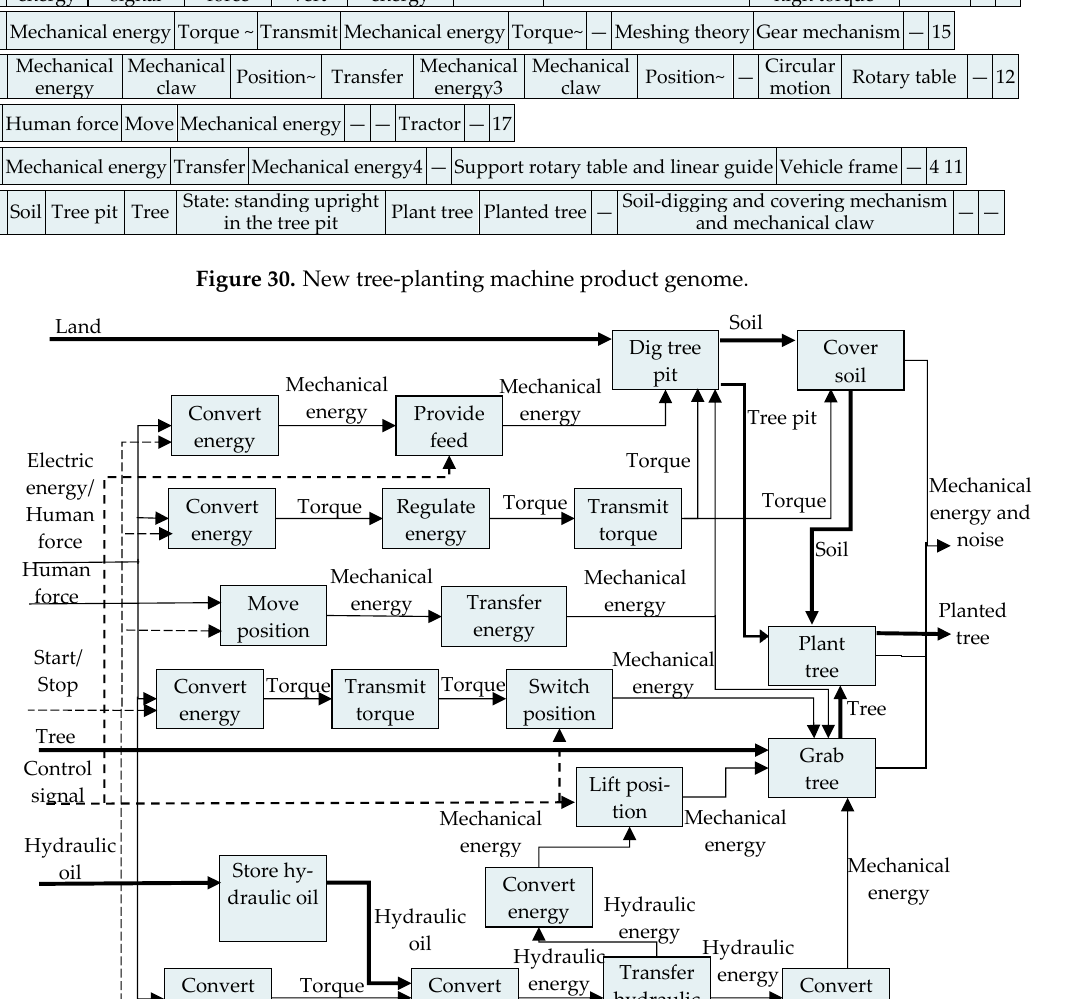
Figure 32. New tree-planting machine concept structure. The concept structure of the soil digging and covering mechanism is shown in Figure 33. When the motor is in forward rotation, the drive shaft is driven to rotate the planetary frame and sun gear together through the stamping of the tension sleeve, and the sleeve is driven to rotate at the same speed. During this process, the soil removed by the spiral drill pipe is collected into the sleeve for storage. When the motor reverses, the tension sleeve releases the pressure so that the drive shaft only drives the sun wheel to turn. At the same time, the sleeve clamping mechanism tightens the sleeve to make it fixed. The collected soil flows out of the sleeve under the reverse rotation of the spiral drill pipe.